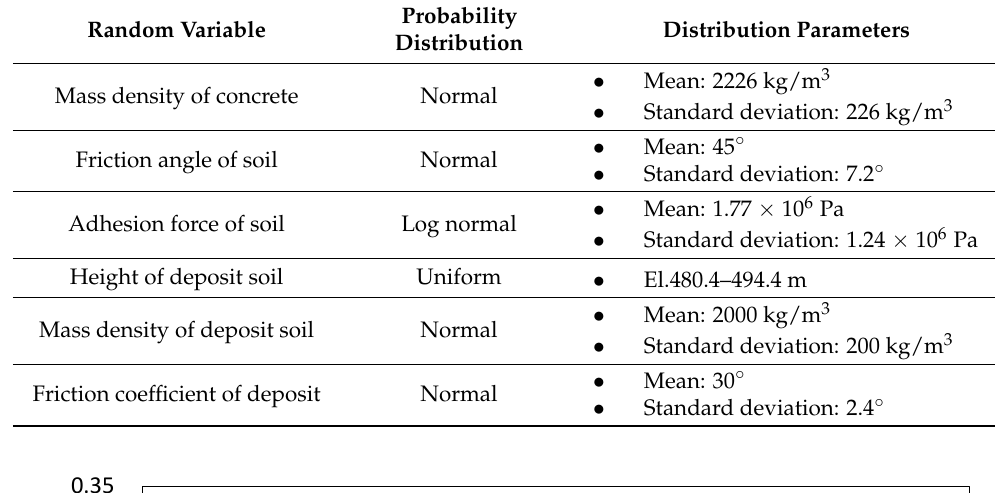
Table 3. Selected random variables.